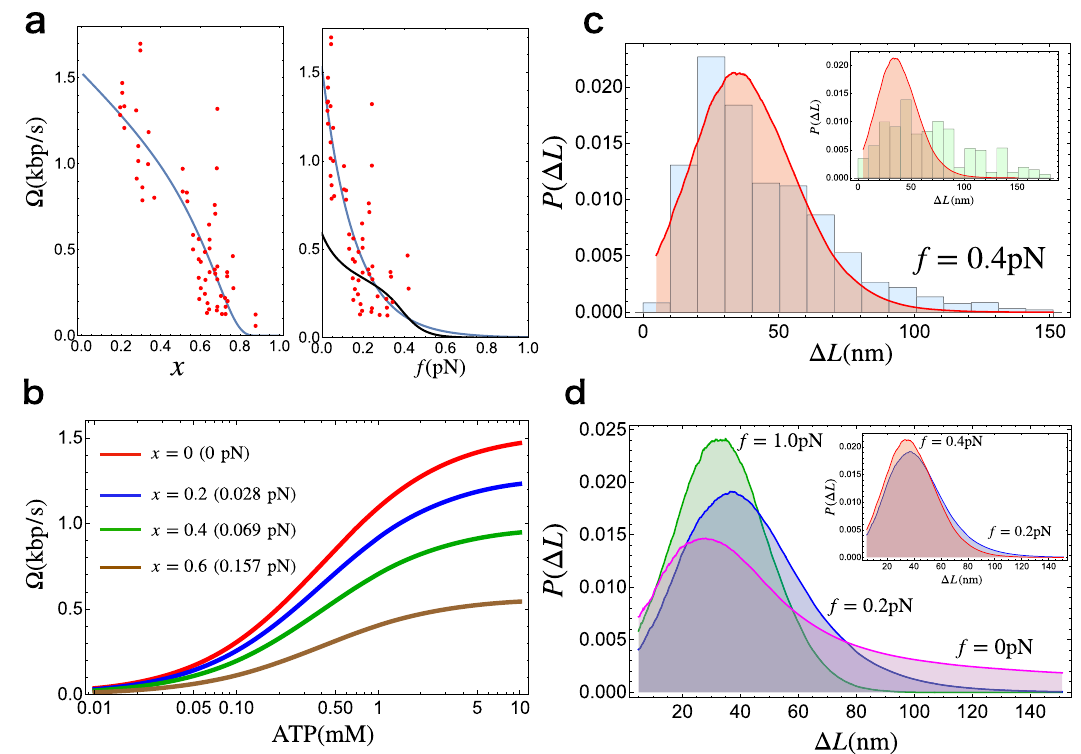
Fig. 4 Analysis of experimental data using theory. a Left panel: The LE velocity as a function of the relative extension of the DNA ( x ). Red dots are experimental data 9 , and the solid blue line is the fi t obtained using Eq. (6). We used l DNA ¼ 50 nm for the persistence length of DNA. Right panel: p Extrusion velocity as a function of the external load acting on DNA ( f ). The blue line is Ω from Eq. (6) and the line in black is reproduced from Fig. 6c in ref. 16 . The unit of LE velocity, nm/s, is converted to kbp/s using the conversion 1 bp = 0.34 nm. b The dependence of LE velocity on ATP concentration for different relative extension of DNA. The parameters used are ^ k 0 ¼ 20 s (cid:2) 1 , Δ R = 26 nm, and K M = 0.4 mM, where K M = 0.4 mM is Michaelis – Menten constant for ATP hydrolysis rate 8 . We used l DNA ¼ 50 nm for the persistence length of DNA. c Distribution of the DNA extrusion length per step ( Δ L ) p using l DNA ¼ 42 nm, which is the value reported in the experiment 20 . The histograms are the experimental data taken from Ryu et al. 20 (blue) and Strick p et al. 58 (inset;green). The distributions in red are the theoretical calculations. The distributions for theory and the experiments are both in f = 0.4 pN. d LE length distributions for various external load on DNA using l DNA ¼ 42 nm 20 . f = 0 pN is in magenta, f = 0.2 pN is in blue, and f = 1.0 pN is in green. The p inset compares the results for f = 0.2 pN and f = 0.4 pN. Data plotted in a , c , and d are provided as a Source Data fi